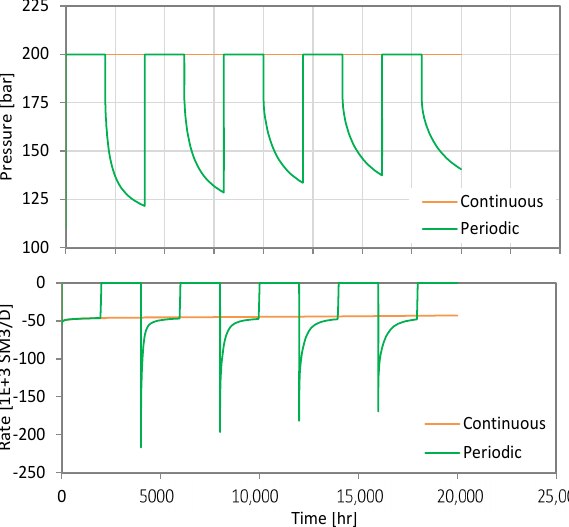
Figure 5. Comparison of continuous and periodic injections of CO 2 into saline aquifer at constant bottom hole pressure condition at the well, 2D numerical simulations in Saphir.